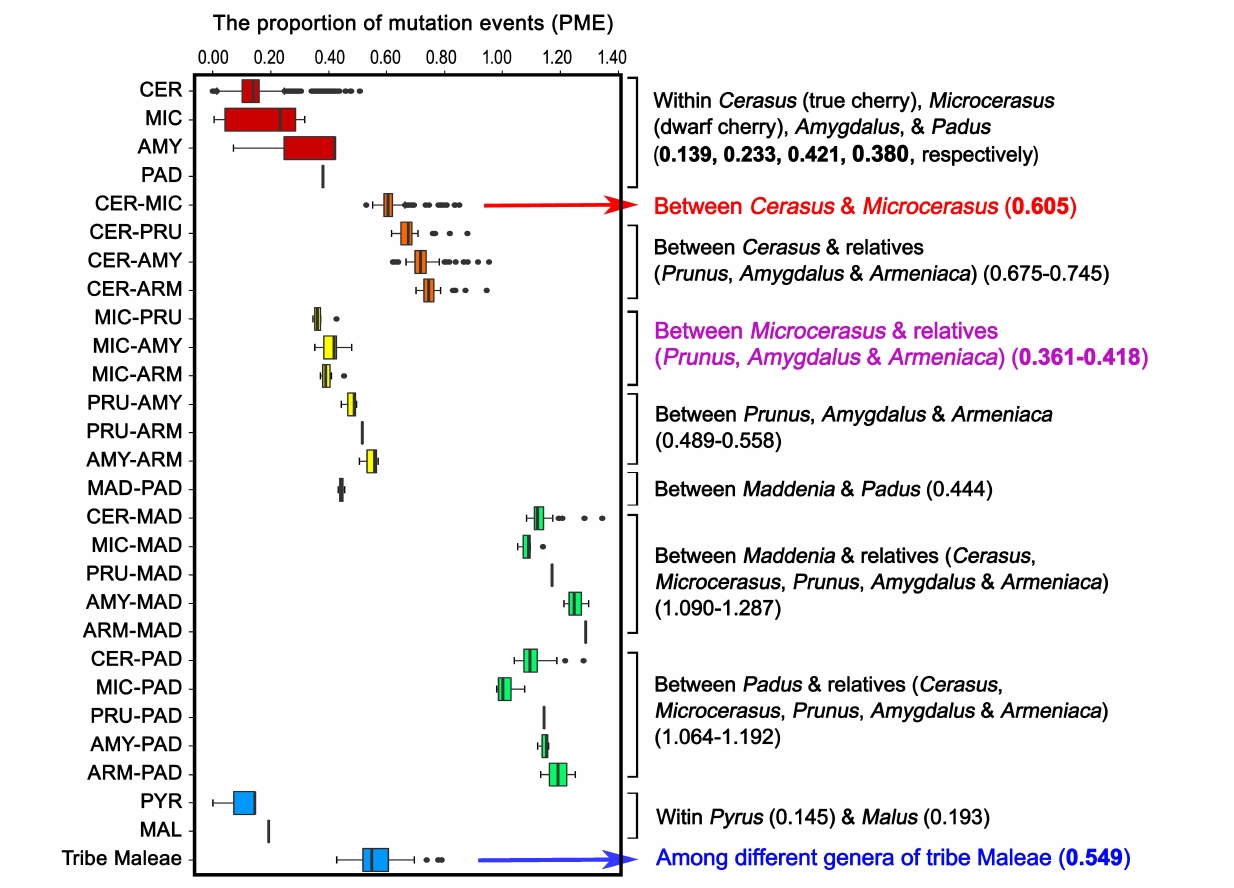
FIGURE 5 | Proportion of mutation events within and among tribes Amygdaleae and Maleae of the Amygdaloideae subfamily. CER, Cerasus (true chery); MIC, Microcerasus (dwarf cherry); AMY, Amygdalus (peach); PAD, Padus (bird cherry and black cherry); PRU, Prunus (plum); ARM, Armeniaca (mei); MAD, Maddenia ; PYR, Pyrus (pear); MAL, Malus